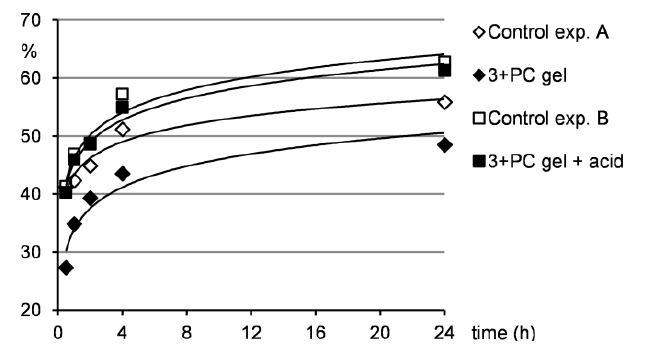
Figure 6. Release of PC from the gel to the water layer under neutral and acidic